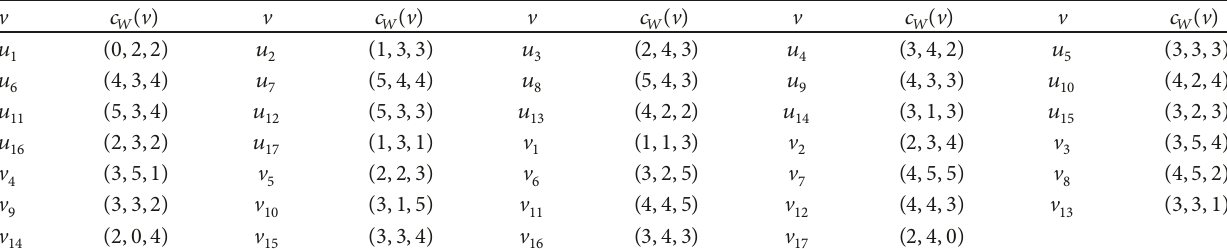
Table 9: The code 𝑐 𝑊 ( V ) of V with respect to 𝑊 = {𝑢 1 , V 14 , V 17 } in 𝑃(17,4)